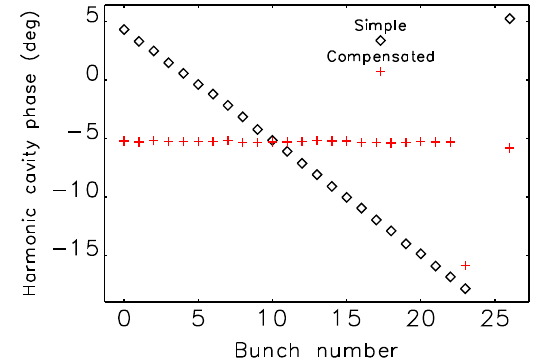
FIG. 20. Loss rate due to Touschek scattering as a function of the number of gaps in a 324-bunch pattern, for simple and compensated gaps, for various gap lengths. The solid lines show linear fits to the data for two-bunch